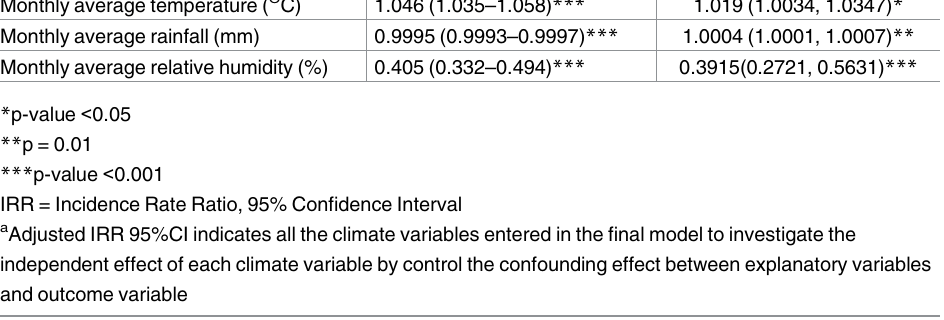
Table 3. Negative binomial regression analysis of the effect of climate variability on childhood diar- rhea in northwest Ethiopia, from July 2013 to June 2015.